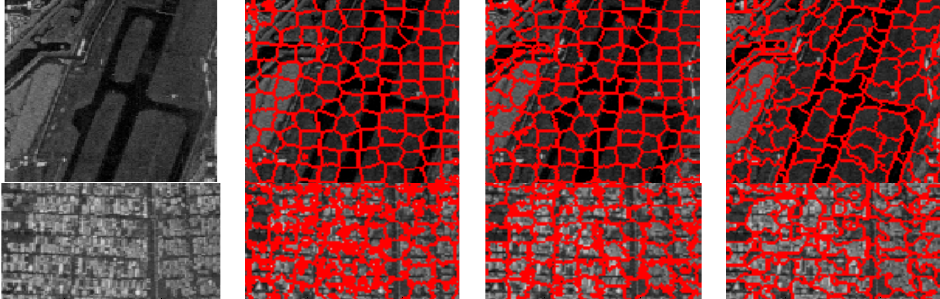
Figure 14. UAVSAR image patches C1 and C2 (first column from top to bottom) and corresponding superpixels provided by standard SLIC (second column), compound method (third column), and proposed algorithm (fourth column).